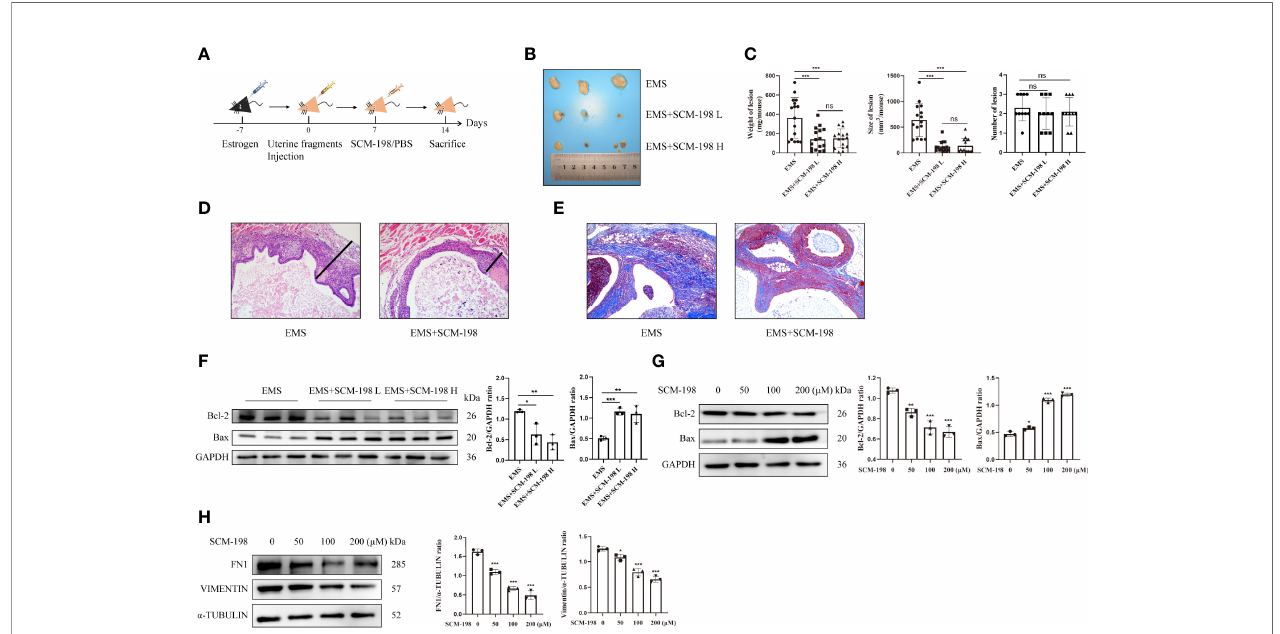
FIGURE 1 | SCM-198 suppresses endometriotic growth both in vivo and in vitro EMS mice were treated with or without SCM-198 at low (EMS+SCM-198 L, 7.5 mg/ kg) or high (EMS+SCM-198 H, 15 mg/kg) doses once daily for 1 week. (A) The fl owchart of the process of establishing the mouse EMS model. (B) Representative images of the ectopic lesions from EMS mice. (C) Quantitative results for the weight (n = 16), size (n = 15), and number (n = 10) of ectopic lesions from EMS mice. (D) Thicknesses of ectopic cyst walls from EMS mice. (E) Masson staining was performed to detect collagen fi bers of ectopic lesions. (F) Western blotting was utilized to analyze the protein levels of Bcl-2 and Bax in ectopic lesions (n = 3). (G, H) The eESCs from EMS patients were treated with different doses of SCM-198 for 48 h, and then Western blotting was used to analyze the protein levels of Bcl-2, Bax, FN1, and vimentin (n = 3). Continuous data are presented as the mean ± SD (* P < 0.05, ** P < 0.01, and *** P < 0.001; ns, not signi fi